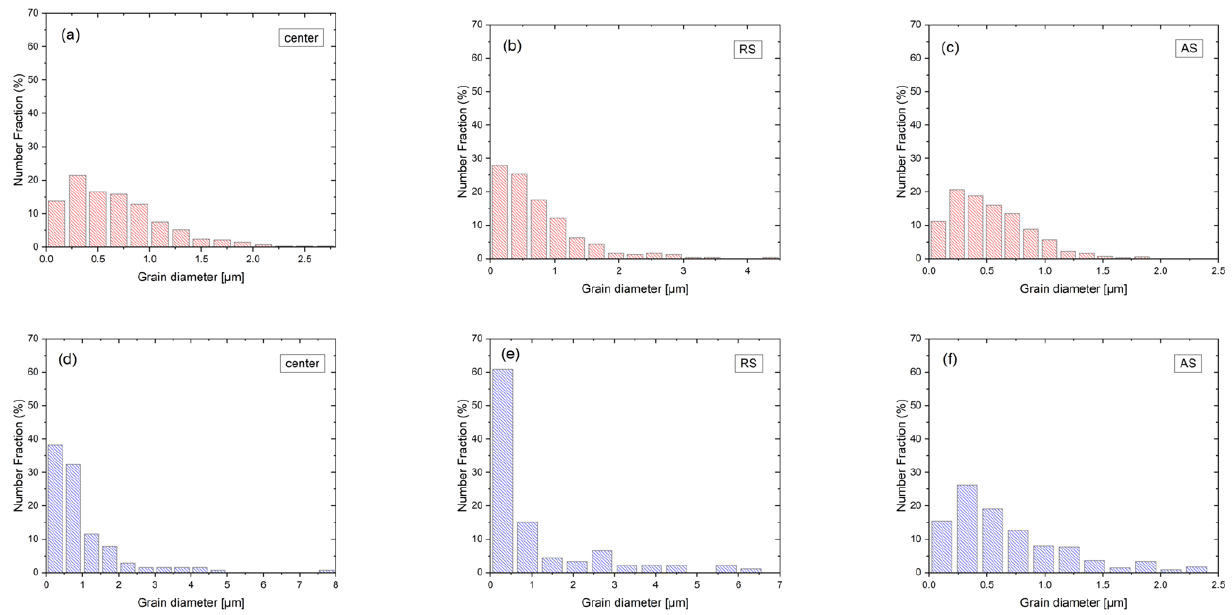
Figure 4. Phase maps of ( a , d ) center, ( b , e ) RS, and ( c , f ) AS (The grain sizes of austenite and ferrite bars are in red and blue, respectively).